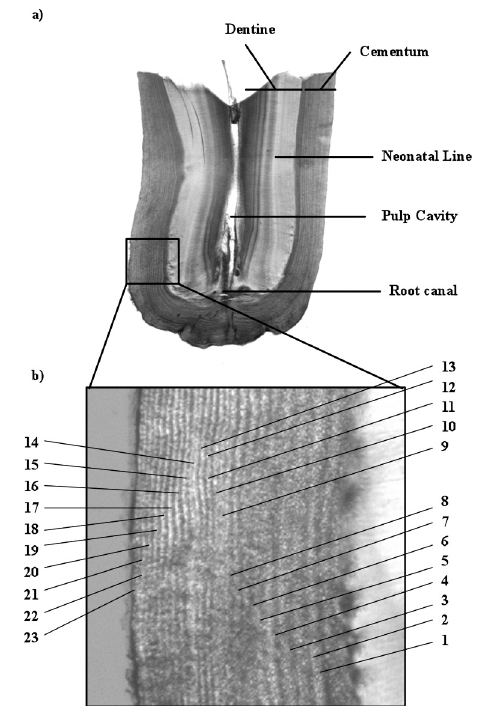
Fig. 2. Example of a decalcified and stained buccal-lingual section from a ringed seal indicating, a) the main tooth structures and, b) how the Growth Layer Groups (GLGs) are counted. This individual was estimated to be 23 years of age at the time of its